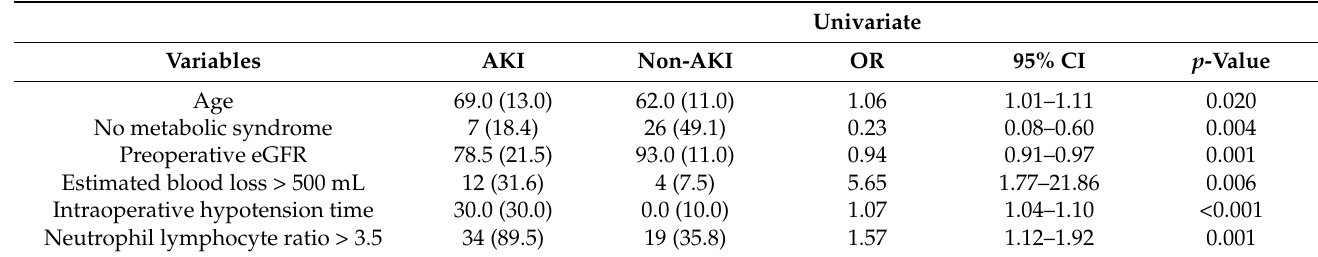
Table 2. Univariate analysis of the associations between clinical characteristics and postoperative